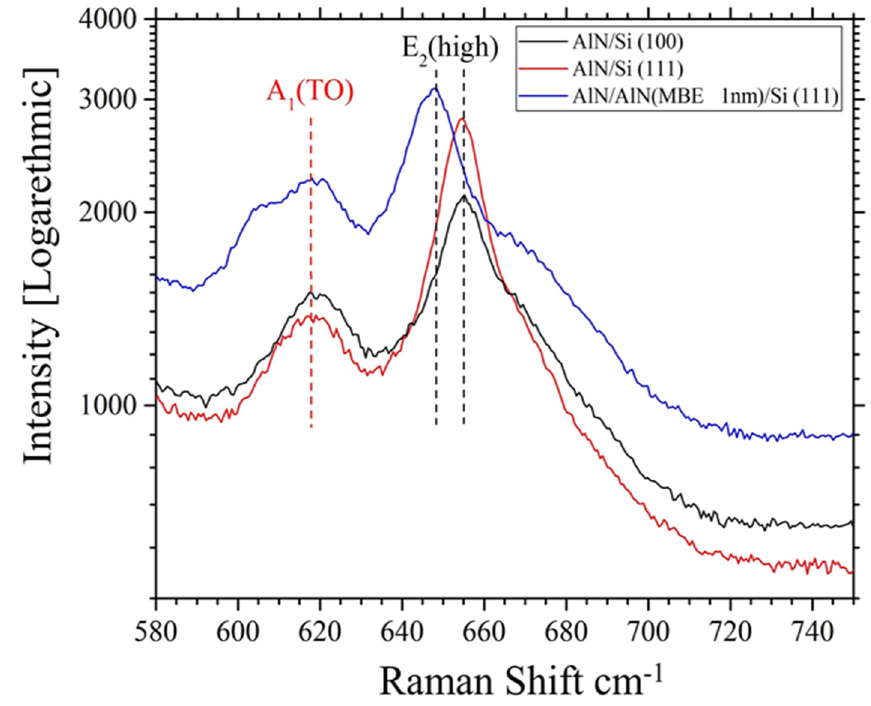
Figure 5. Raman spectra of AlN thin films deposited by DCMS on different substrates.